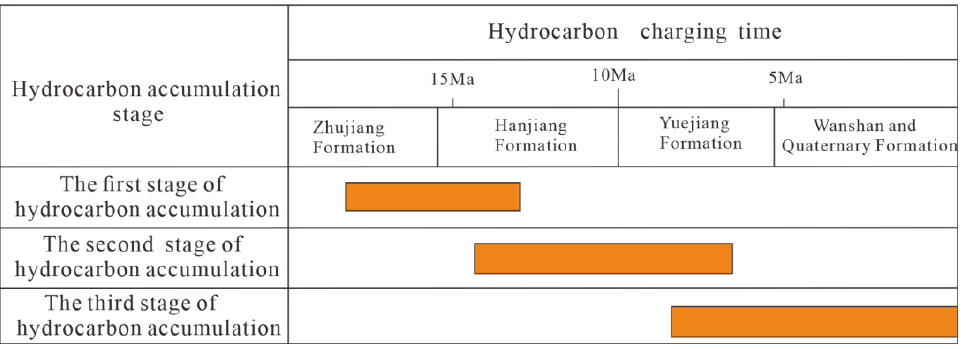
Figure 10. Relationship between hydrocarbon accumulation stages and oil and gas charging time.